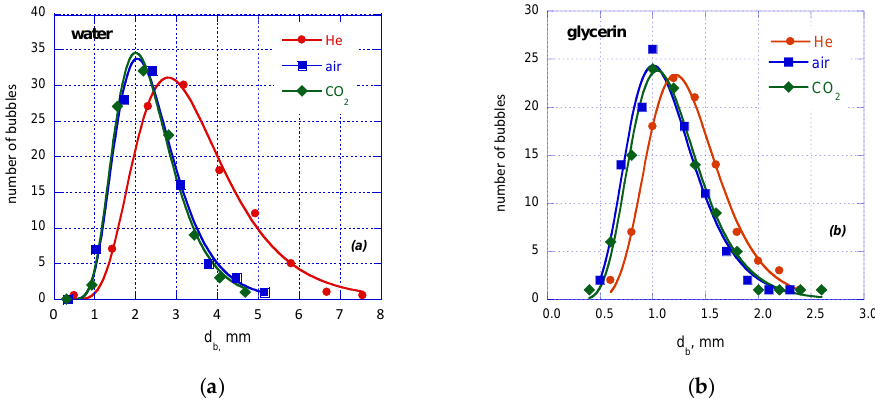
= 0.01 m/s.): ( a ) water; ( b ) glycerin sol. GS